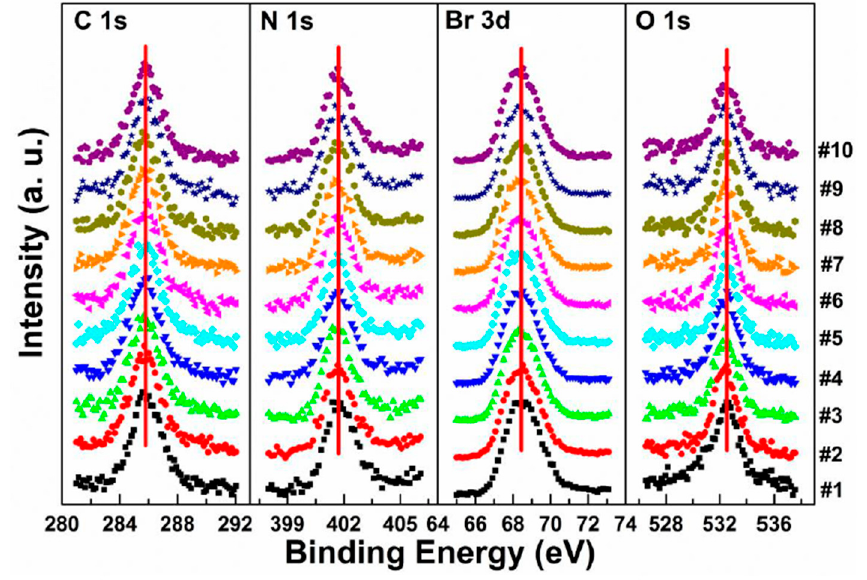
Figure 7. Evolutions of C 1s, N 1s, Br 3d, and O 1s XPS spectra of cleaved MAPbBr 3 single crystal under X-ray exposure. From Ref. [38]. with permission.